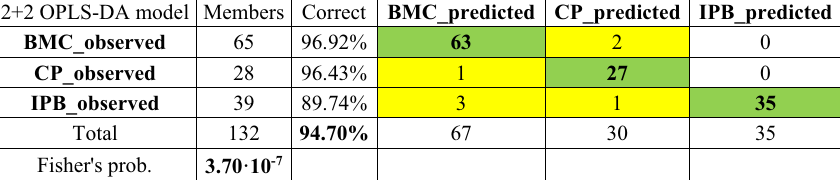
Table 1. Misclassification table obtained for the OPLS-DA model, built on the BMC, IPB, and CP classes, by using the work-set itself as the